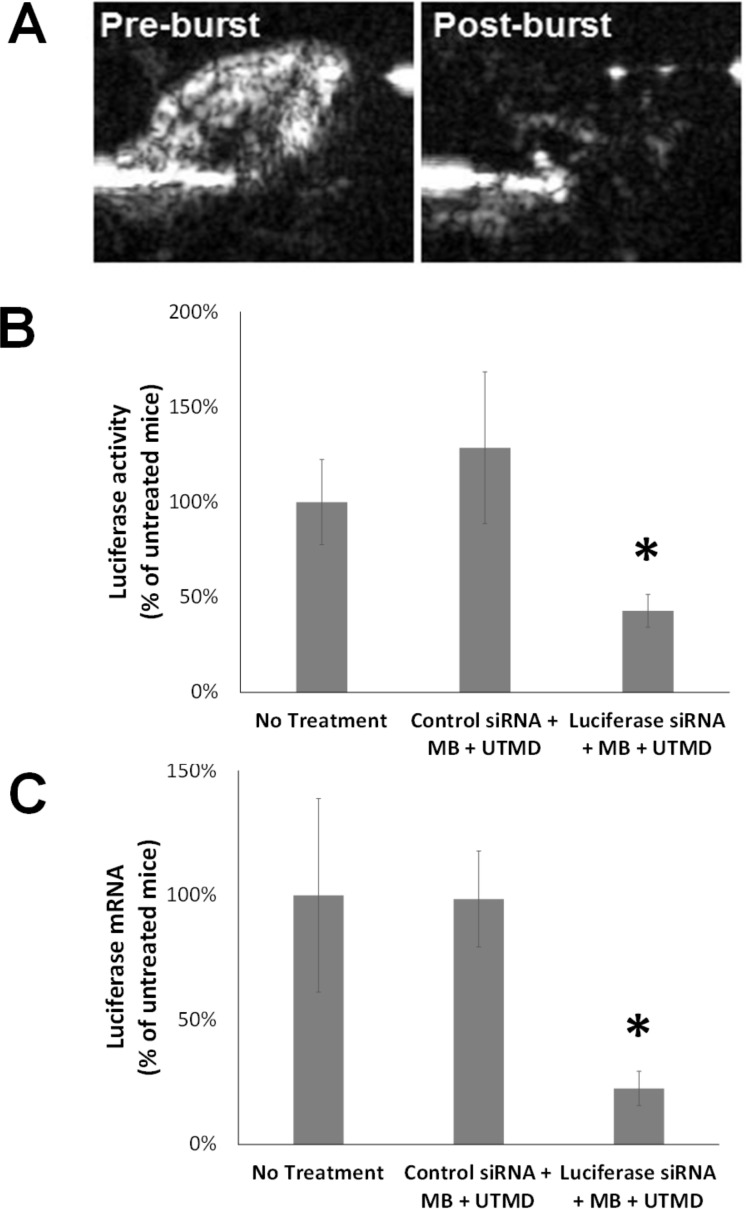
Ultrasound and Microbubble Delivery of siRNA to the Heart.Therapeutic ultrasound during transit of luciferase siRNA-loaded MB through the heart causes microbubble destruction and reduces cardiac luciferase expression. (A) Contrast pulse sequence imaging of mouse heart before (pre-burst) and after (post-burst) UTMD. (B) Normalized luciferase activity (±SE) in the ventricles of mice 3 days after intravenous delivery of negative control siRNA-loaded MBs (NC-MB) + UTMD (n = 8) or luciferase siRNA-loaded MB (Luc-MB) + UTMD (n = 9). (C) Normalized luciferase mRNA levels (±SE), as assayed by RT-PCR, in the ventricles of mice 3 days after delivery of negative control siRNA-loaded MB (NC-MB) + UTMD (n = 7) or luciferase siRNA-loaded MB (Luc-MB) + UTMD (n = 8). * indicates significant differences between treated groups (p<0.05) by Mann-Whitney test.